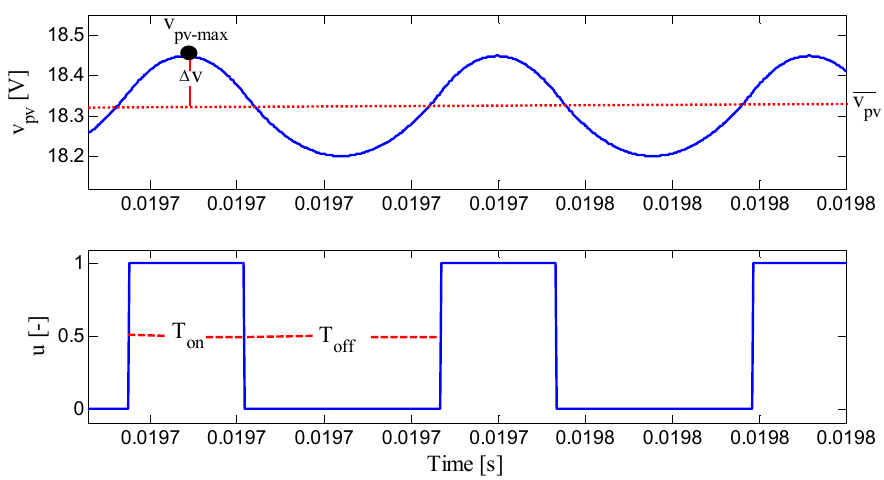
Figure 10. Principle for calculating the switching frequency.